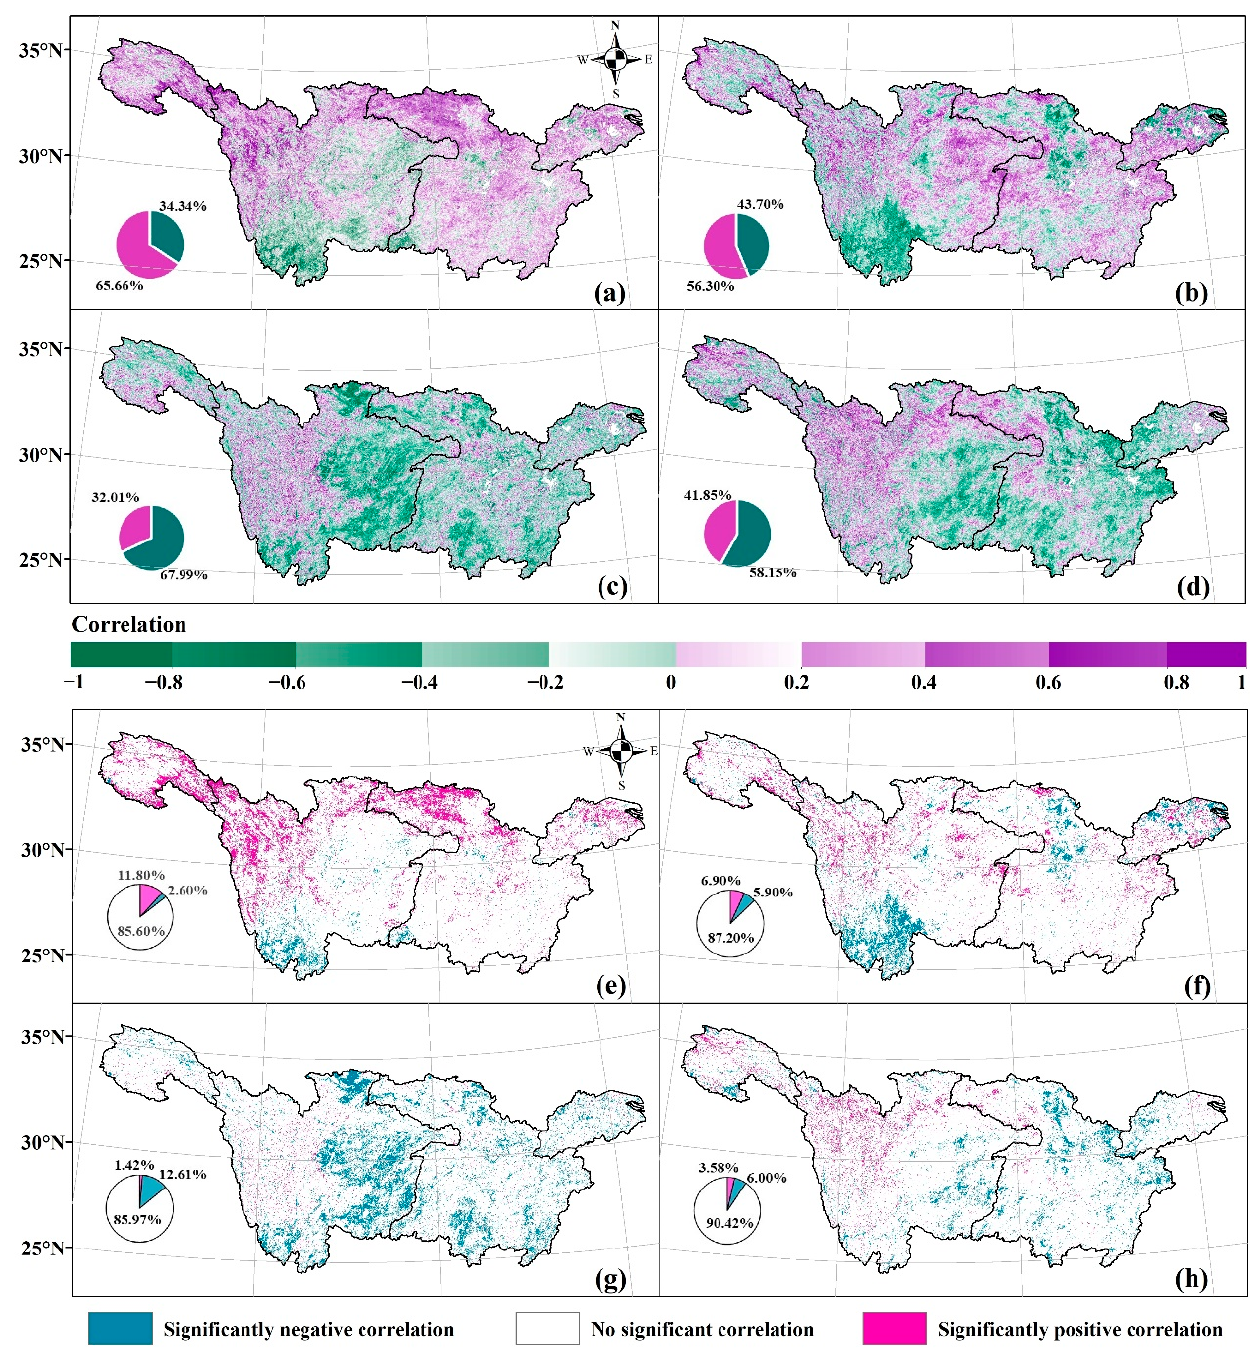
Figure 9. Correlation coefficient between LST and NDVI in winter ( a , e ); spring ( b , f ); summer ( c , g ); and autumn ( d , h ) from 2003 to 2021. The inset pie charts show the percentage of area with a positive correlation and negative correlation, respectively ( a – d ), and the percentage of area with a significantly positive correlation, significantly negative correlation and insignificant relationship, respectively ( e – h ).